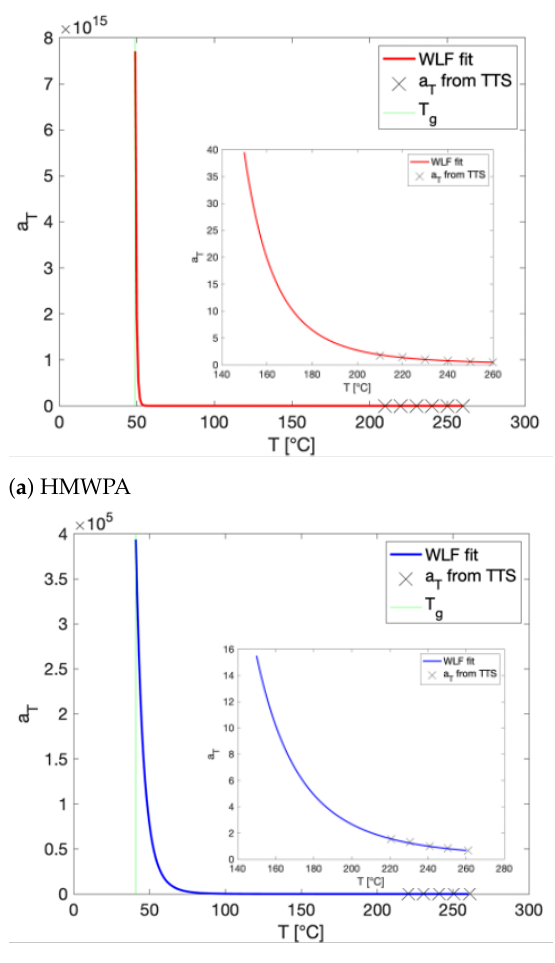
Figure A5. The shift factors a T obtained from time-temperature superposition (TTS) on rheological data measured in the melt state with their WLF fit to extrapolate their temperature dependence up until T g for ( a ) HMWPA and ( b )